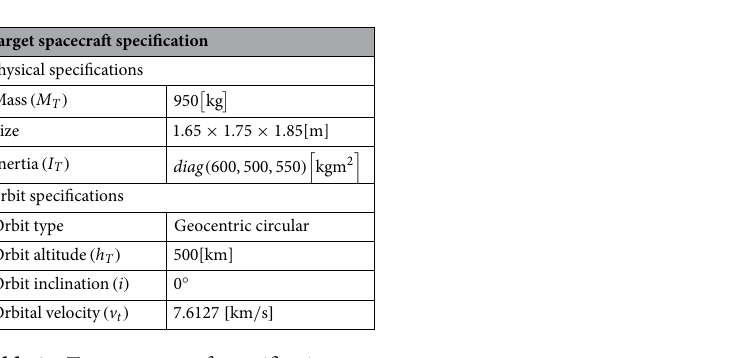
Table 2. Target spacecraft